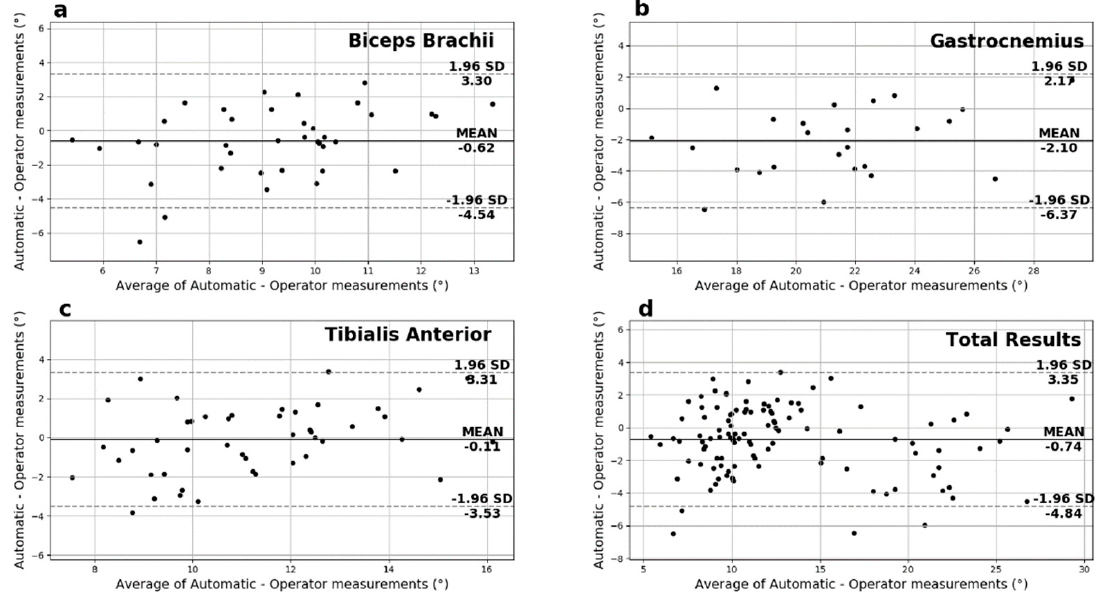
Figure 9. Pennation angle’s Bland − Altman plots for ( a ) biceps brachii, ( b ) gastrocnemius medialis, ( c ) tibialis anterior, and ( d ) overall.